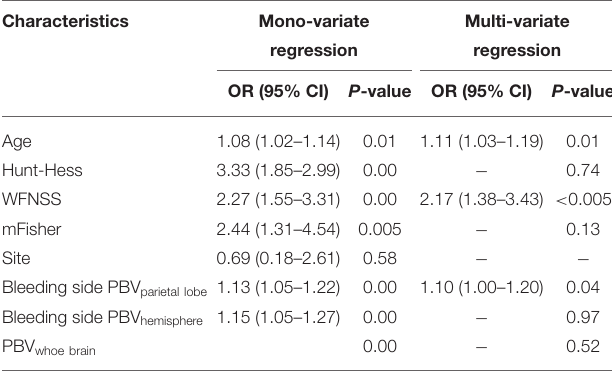
TABLE 4 | Multivariate logistic regression analysis (forward) of factors associated with outcome at discharge.